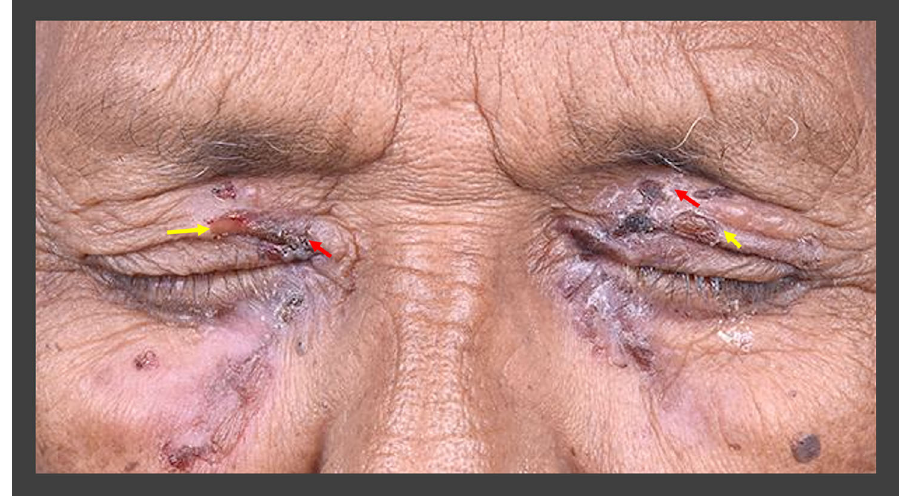
Figure 7. Periocular blisters around both eyes in case 4. Some of the blisters have ruptured (yellow arrows) while the others are crusted over (red